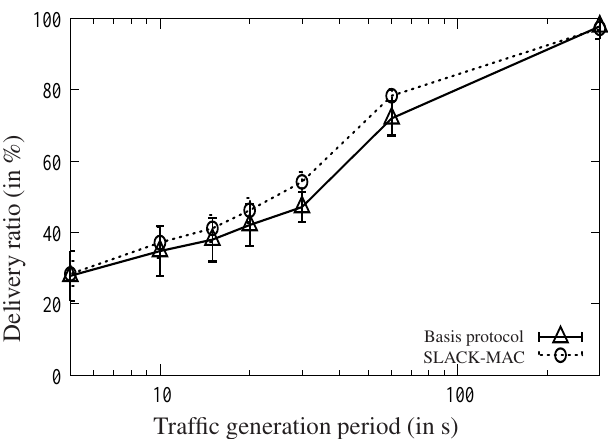
Figure 11. Delivery ratio as a function of the traffic generation period, for a duty-cycle of 1%, and for the Basic protocol and SLACK-MAC.